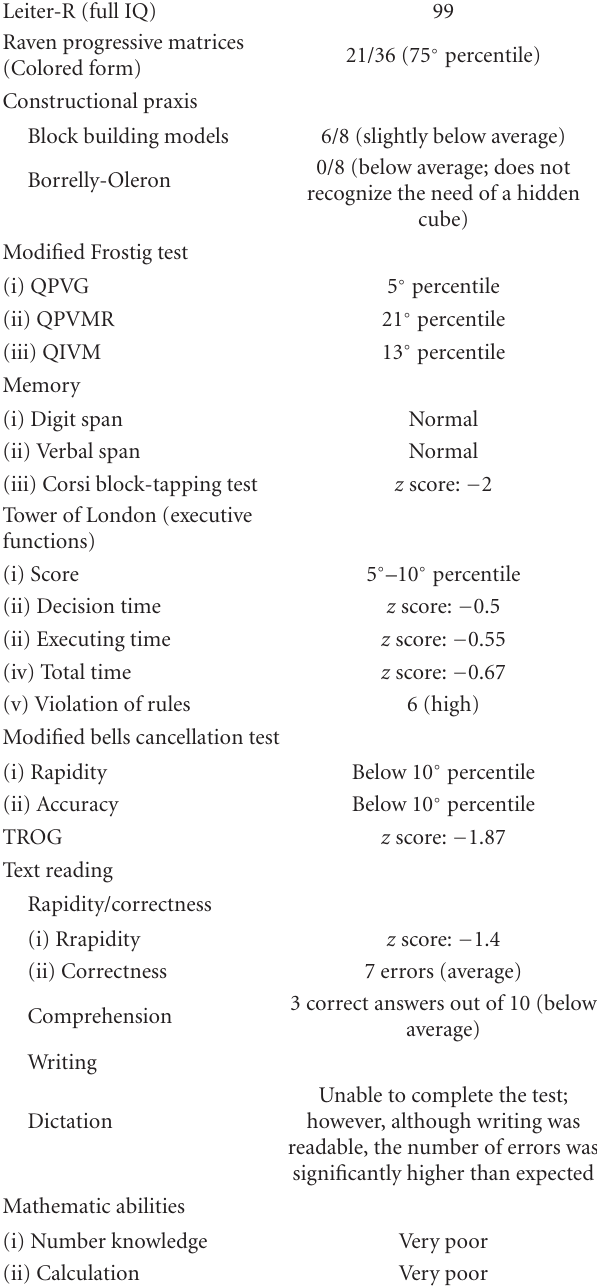
Table 1: Neuropsychological profile of the